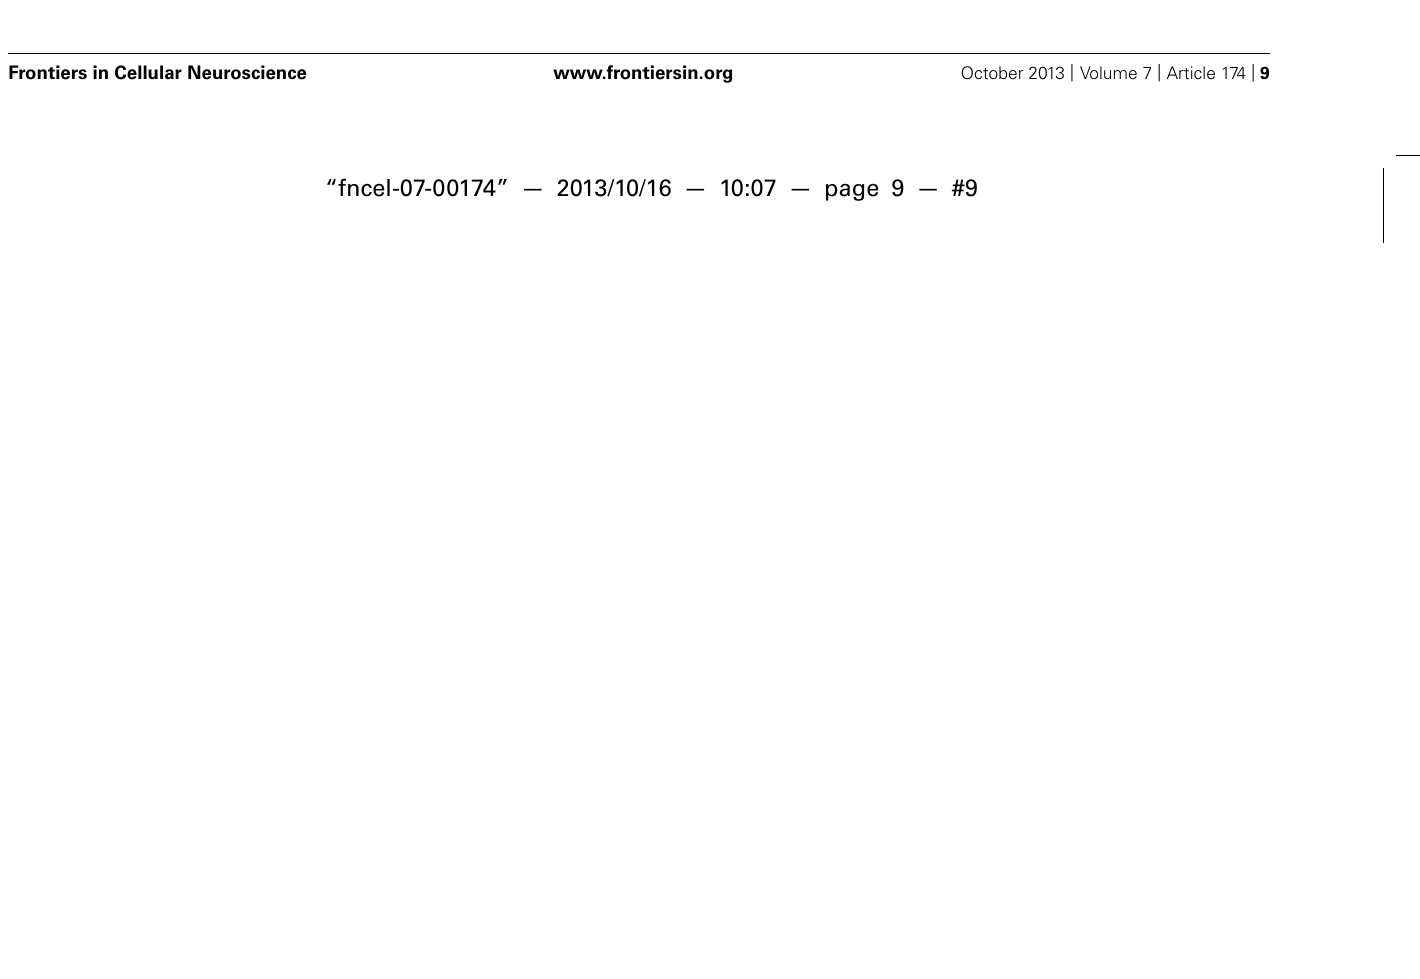
Table 3 |Action potential waveform properties of M1 layer 5 projection neurons (26 ◦